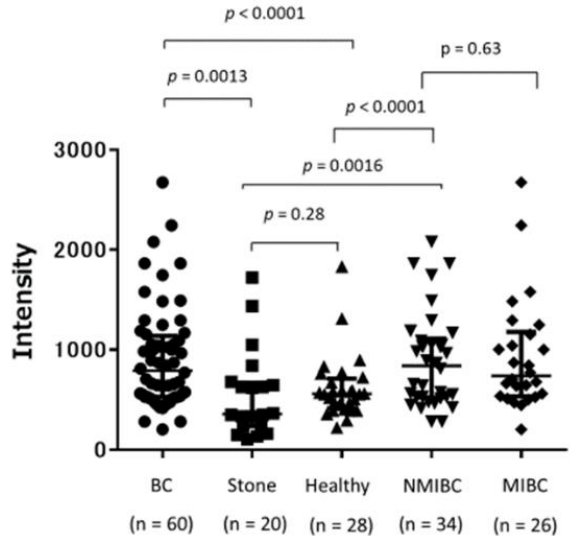
Figure 1. Serum epiplakin expression levels in patients with stone disease, healthy volunteers, and patients with bladder cancer. Serum epiplakin levels were significantly higher in patients with bladder cancer than in those with stone diseases and in healthy volunteers. Serum epiplakin levels were also significantly higher in patients with NMIBC than in those with stone diseases and in healthy volunteers. NMIBC: non-muscle-invasive bladder cancer, MIBC: muscle-invasive bladder cancer.